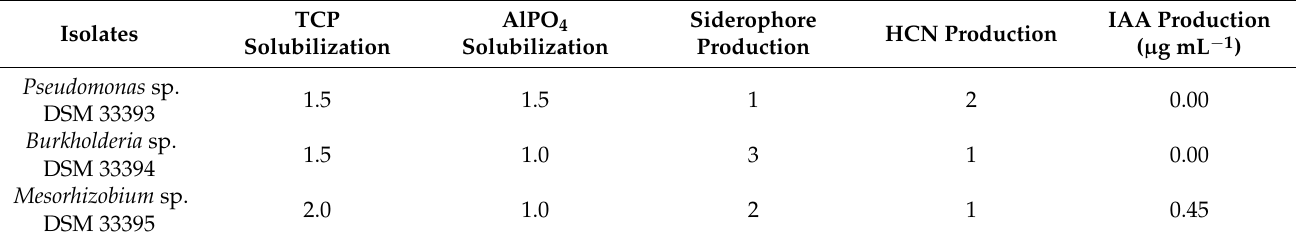
Table 2. Plant growth-promoting mechanisms of